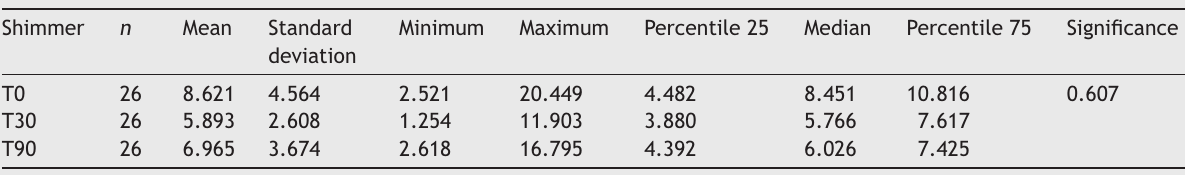
Shimmer --- Vowel /a/. Shimmer